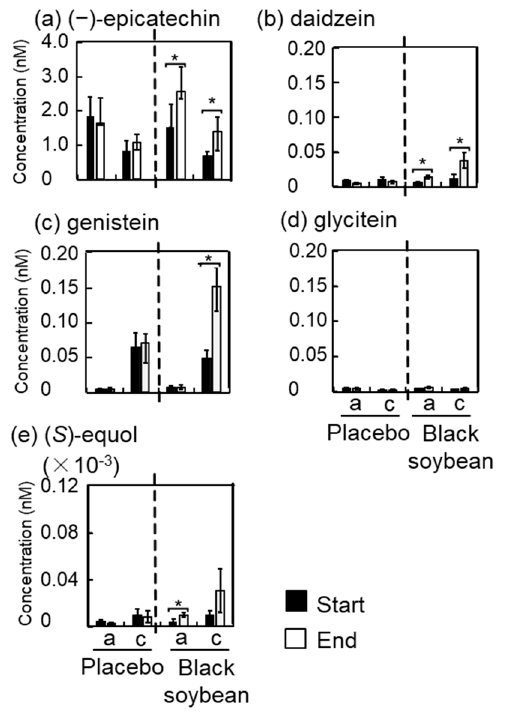
Figure 1. The effect of black soybean consumption on polyphenol concentration in the plasma; a: aglycone form, c: conjugates form. Each panel showed ( a ) ( − )-epicatechin, ( b ) daidzein, ( c ) genistein, ( d ) glycitein, and ( e ) (S)-equol, respectively. The results are represented as the means ± standard deviation. * p < 0.05 vs. start by Welch’s t test .